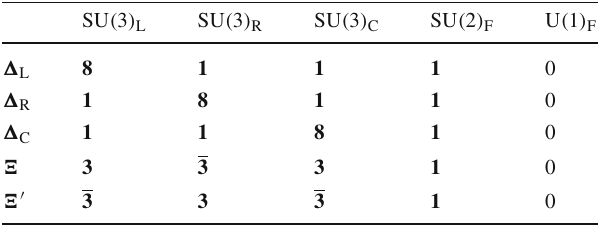
Table 4 Quantum numbers of the fundamental chiral superfields with respect to various subgroups